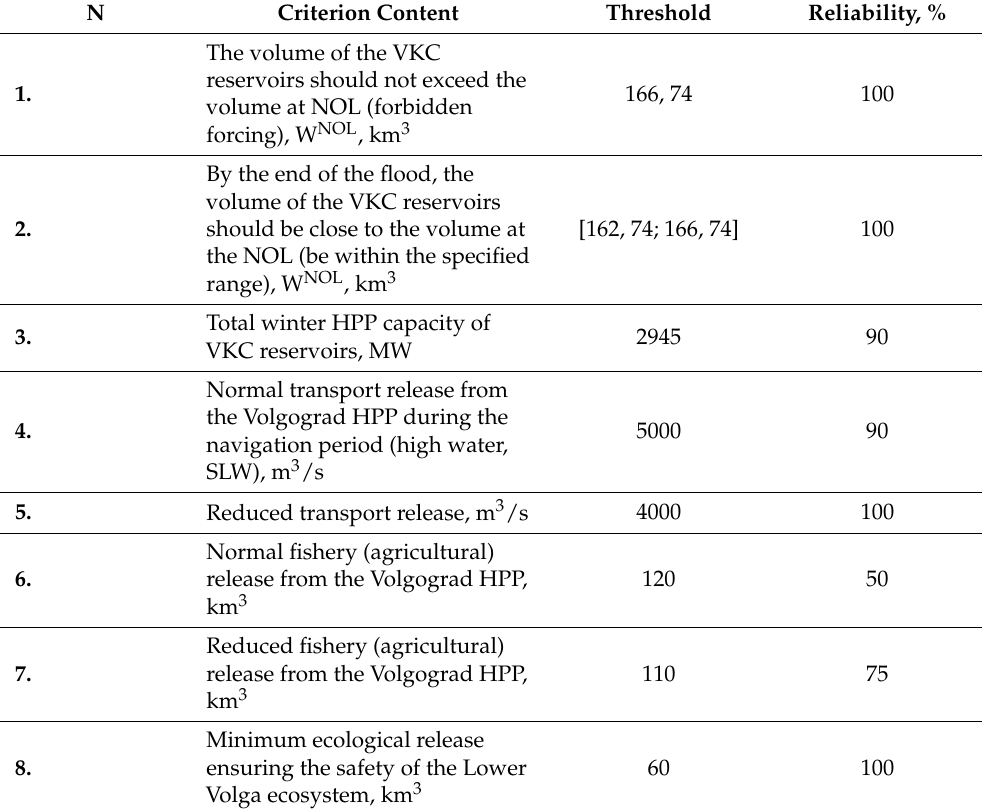
Table 2. Requirements of water users of the VKC water management